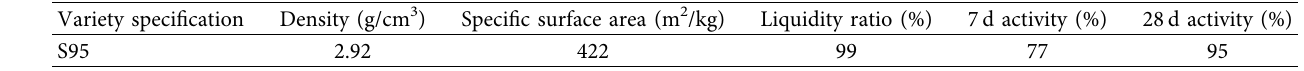
Table 4: Technical indicators of slag powder.